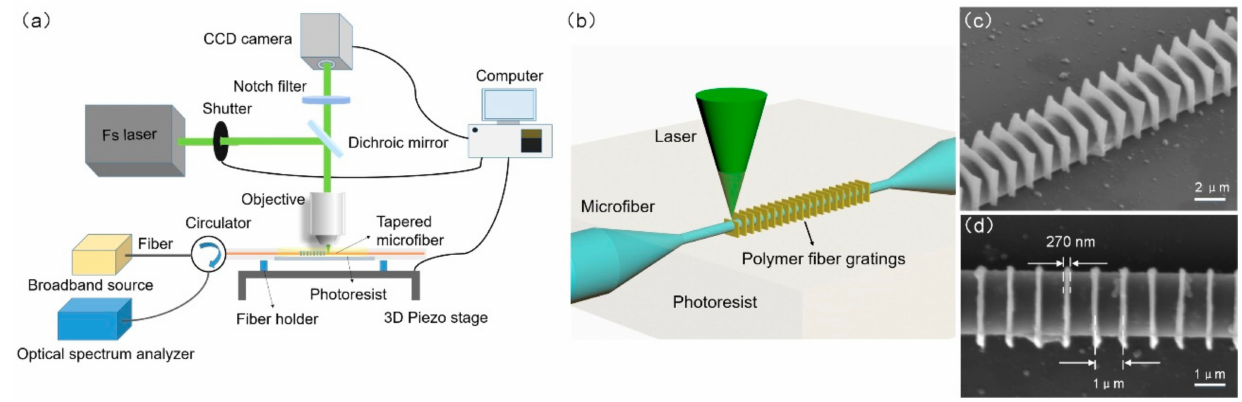
Figure 1. ( a ) Experimental setup of the femtosecond laser nanofabrication of the fully encircled µ -PFBG device. ( b ) Schematic diagram of the process of the novel µ -PFBG fabrication. ( c , d ) are the SEM images of this fully encircled µ -PFBG at angles of 45 ◦ and 0 ◦ ,